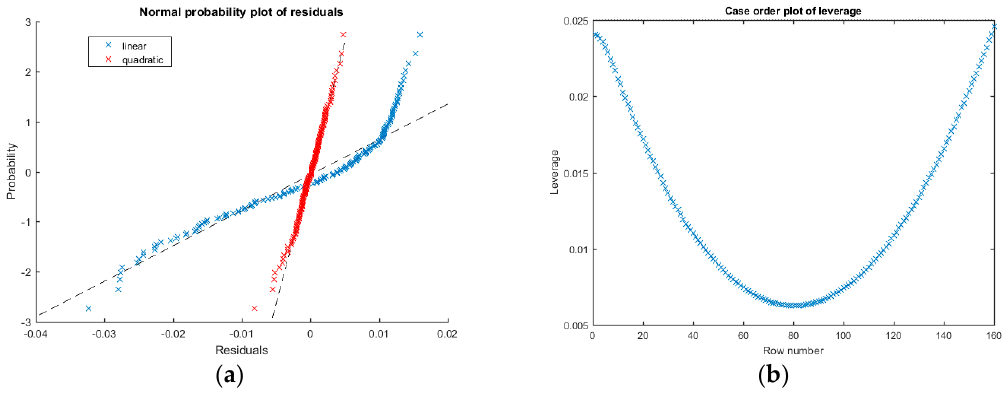
Figure 11. ( a ) Normal probability plot of the residuals of the fitted model: linear (blue) and quadratic (red); ( b ) Leverage plot of data and model